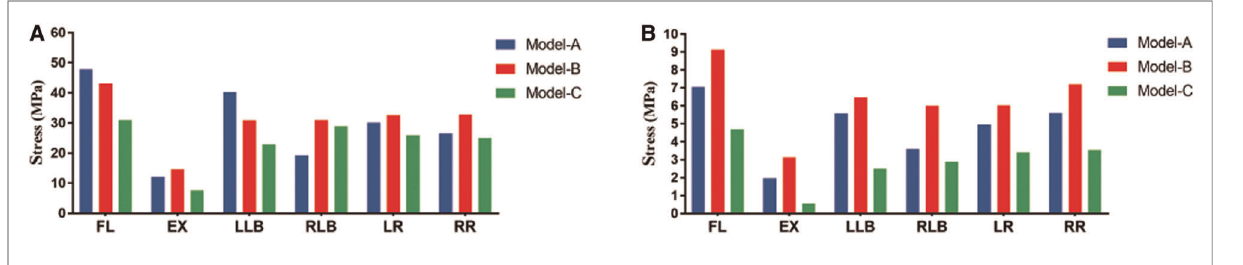
FIGURE 7 ( A ) Peak stress of the cage. ( B ) Average stress of the